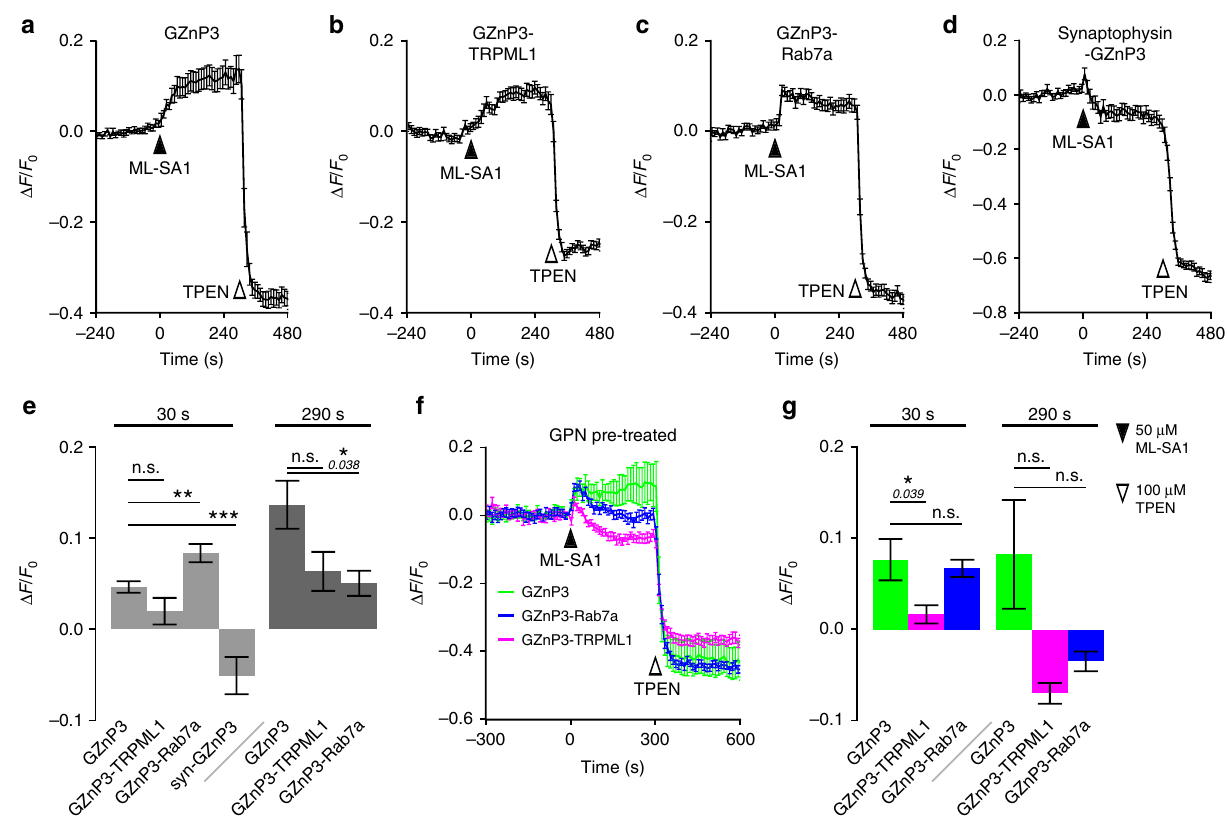
Fig. 5 Activation of TRPML1 promotes Zn 2 + release from lysosomes and late endosomes, not synaptic vesicles. Average traces (±s.e.m.) of primary rat hippocampal neurons a coexpressing mCherry-TRPML1 and GZnP3, b expressing GZnP3-TRPML1, c coexpressing mCherry-TRPML1 and GZnP3-Rab7a, or d coexpressing mCherry-TRPML1 and synaptophysin-GZnP3, treated with 50 µ M ML-SA1 at 0 s and 100 µ M TPEN at 300 s. e Mean normalized GZnP3 signal (±s.e.m.) 30 and 290 s after ML-SA1 addition for cytosolic GZnP3 ( n = 10 neuron soma), GZnP3-TRPML1 ( n = 48 puncta from 5 neuron soma), GZnP3-Rab7a ( n = 62 puncta from nine neuron soma), and synaptophysin-GZnP3 (syn-GZnP3; n = 45 puncta from three neurons). Two-tailed student ’ s t -tests with Bonferroni correction for multiple comparisons. f Average traces (±s.e.m.) of primary rat hippocampal neurons coexpressing mCherry-TRPML1 and cytosolic GZnP3 (green), GZnP3-Rab7a (blue), or expressing GZnP3-TRPML1 (magenta), treated with 200 µ M GPN from -600 to -480 seconds (not shown). g Mean normalized GZnP3 signal (±s.e.m.) 30 and 290 s after ML-SA1 addition for cytosolic GZnP3 ( n = 6 neuron soma), GZnP3-TRPML1 ( n = 30 puncta from four neuron soma), GZnP3-Rab7a ( n = 51 puncta from six neuron soma). One-tailed student ’ s t -tests with